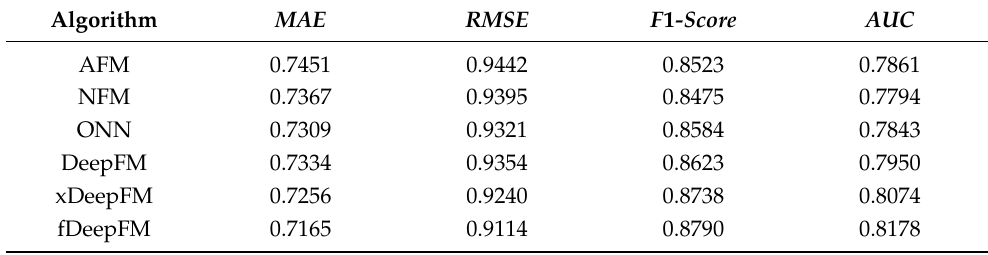
Table 1. Numerical comparison of evaluation indexes of the algorithm in MovieLens-20M data set.